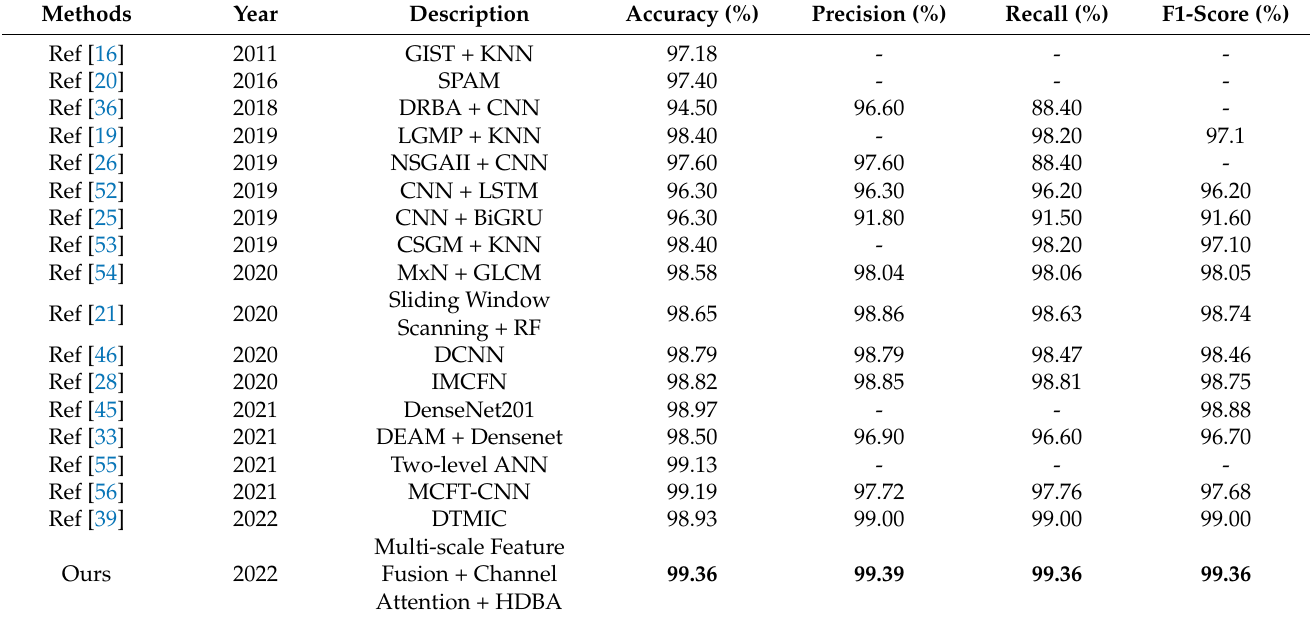
Table 10. Results of a comparative assessment with recent state-of-the-art